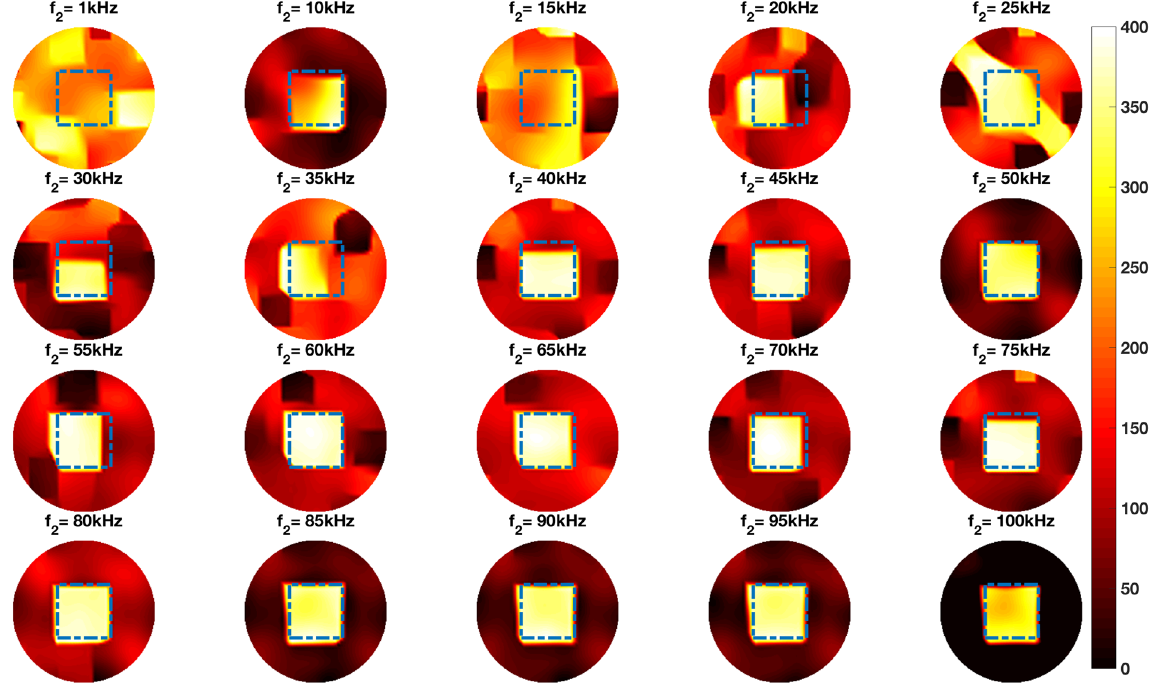
Figure 9. Reconstructed frequency difference images of a steel cube (side length 38.00 mm) positioned in the centre of the imaging region (experimental setup shown in Fig.